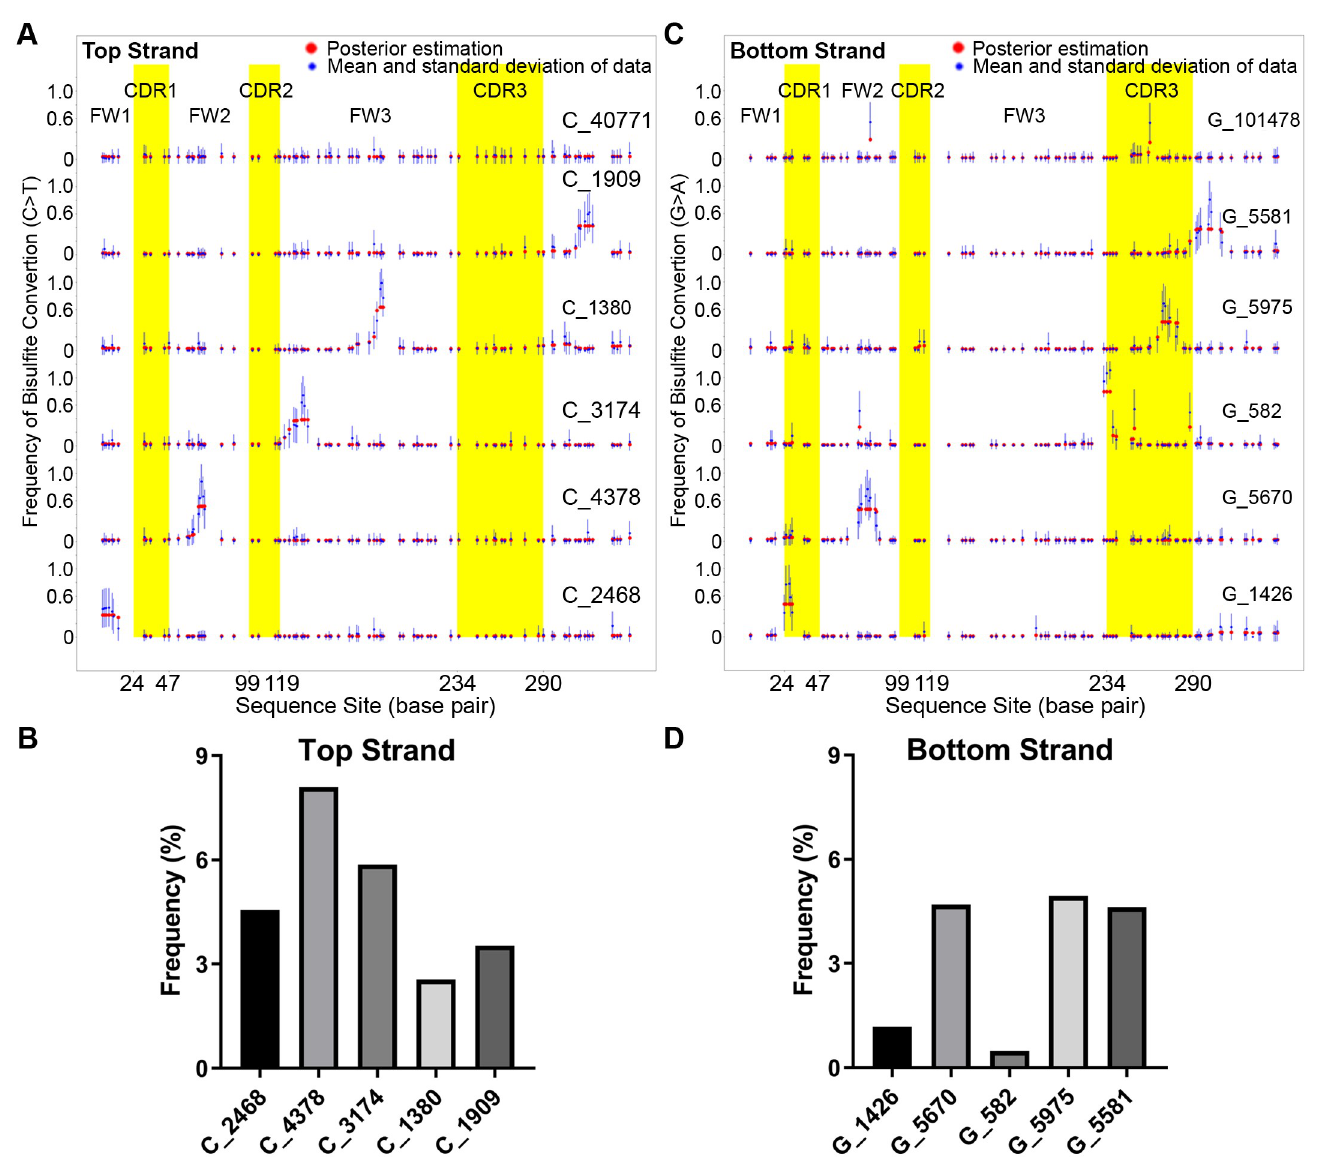
Fig 2. Distribution of bisulfite accessible regions in IGHV4–34 of Ramos analyzed by Bayesian segmentation model. (A) Distribution of the bisulfite accessible regions in the top strand as indicated by C > T mutations. Sequences were clustered by hierarchical clustering and then the patch boundary in each cluster was determined by the Bayesian Segmentation Algorithm. Blue dots with error bars represent the frequency of converted C in each nucleotide position and the red dots indicate the probability of having a converted C using the Bayesian Segmentation Algorithm. The number of sequences in each cluster is listed at the right side of the corresponding cluster. The first cluster (at the top) does not have a typical patch region. The X axis is the nucleotide position within the IGHV4–34 sequence in Ramos. The regions in yellow color background are CDR1, CDR2, and CDR3 from left to right. (B) The frequency of cluster with bisulfite accessible region. For each cluster, the frequency was calculated as the ratio of sequences in the cluster among all sequences. (C) Distribution of bisulfite accessible regions in bottom strand determined by G > A mutation. (D) Frequency of cluster with bisulfite accessible region in bottom strand. The order of the columns corresponds to the clusters, from bottom to top, of panel